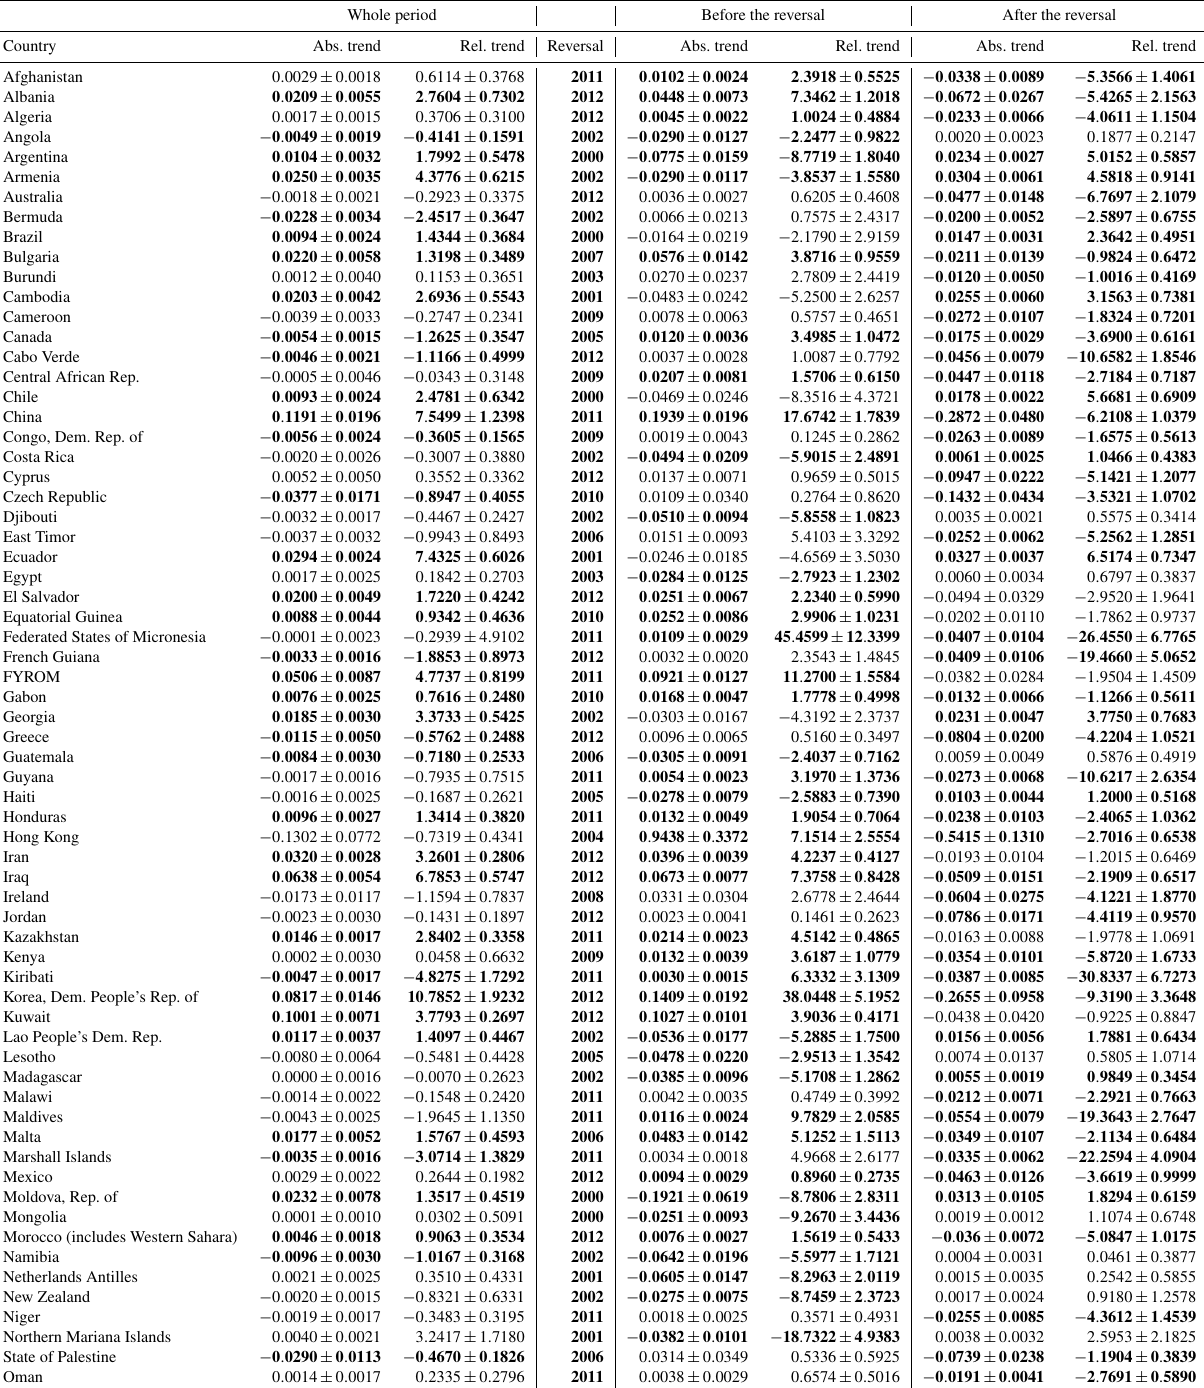
Table 2. The same as Table 1 but for countries. In order to save space, only countries that exhibit a trend reversal are shown here, while results for all the world countries are given in Table S1 of the Supplement. Bold characters are used to indicate the year of reversal and the statistically significant trends at the 95% confidence